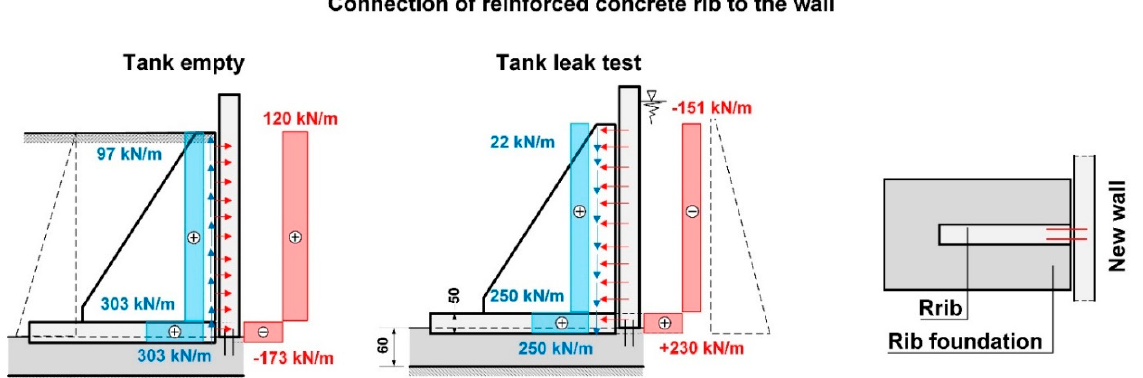
Figure 18. Design values for determining the wall-rib connection based on FEM calculations.